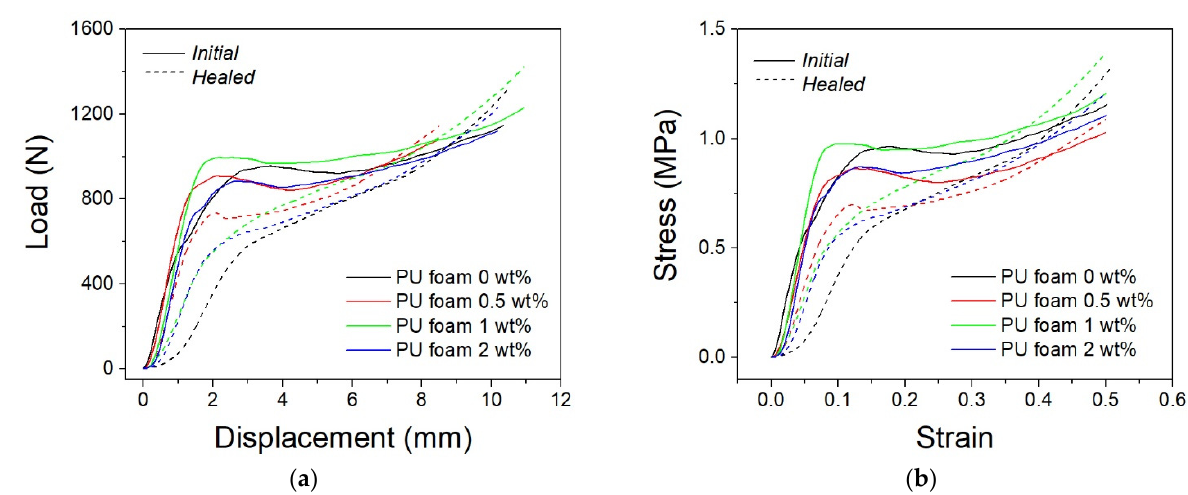
Figure 7. Load–displacement ( a ) and stress–strain ( b ) curves of PU cylindrical foams at initial state and after recovery.